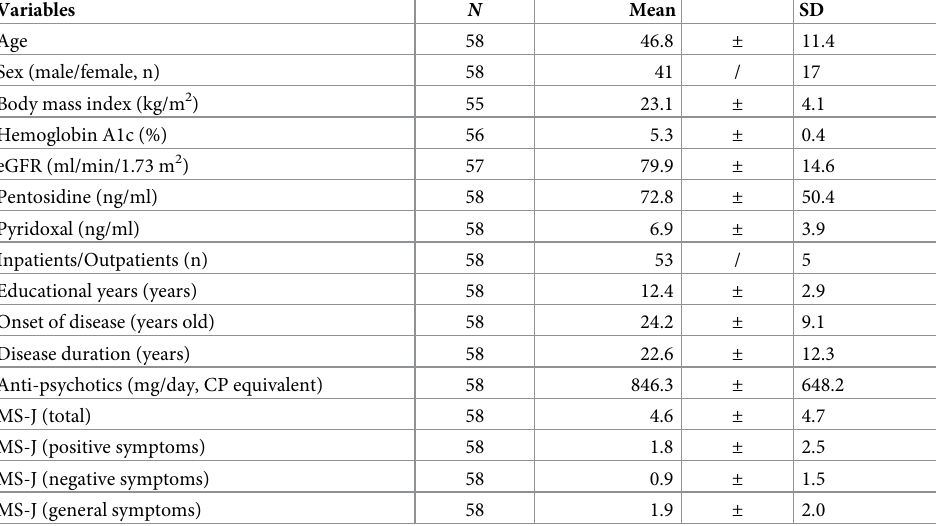
Table 1. Participant